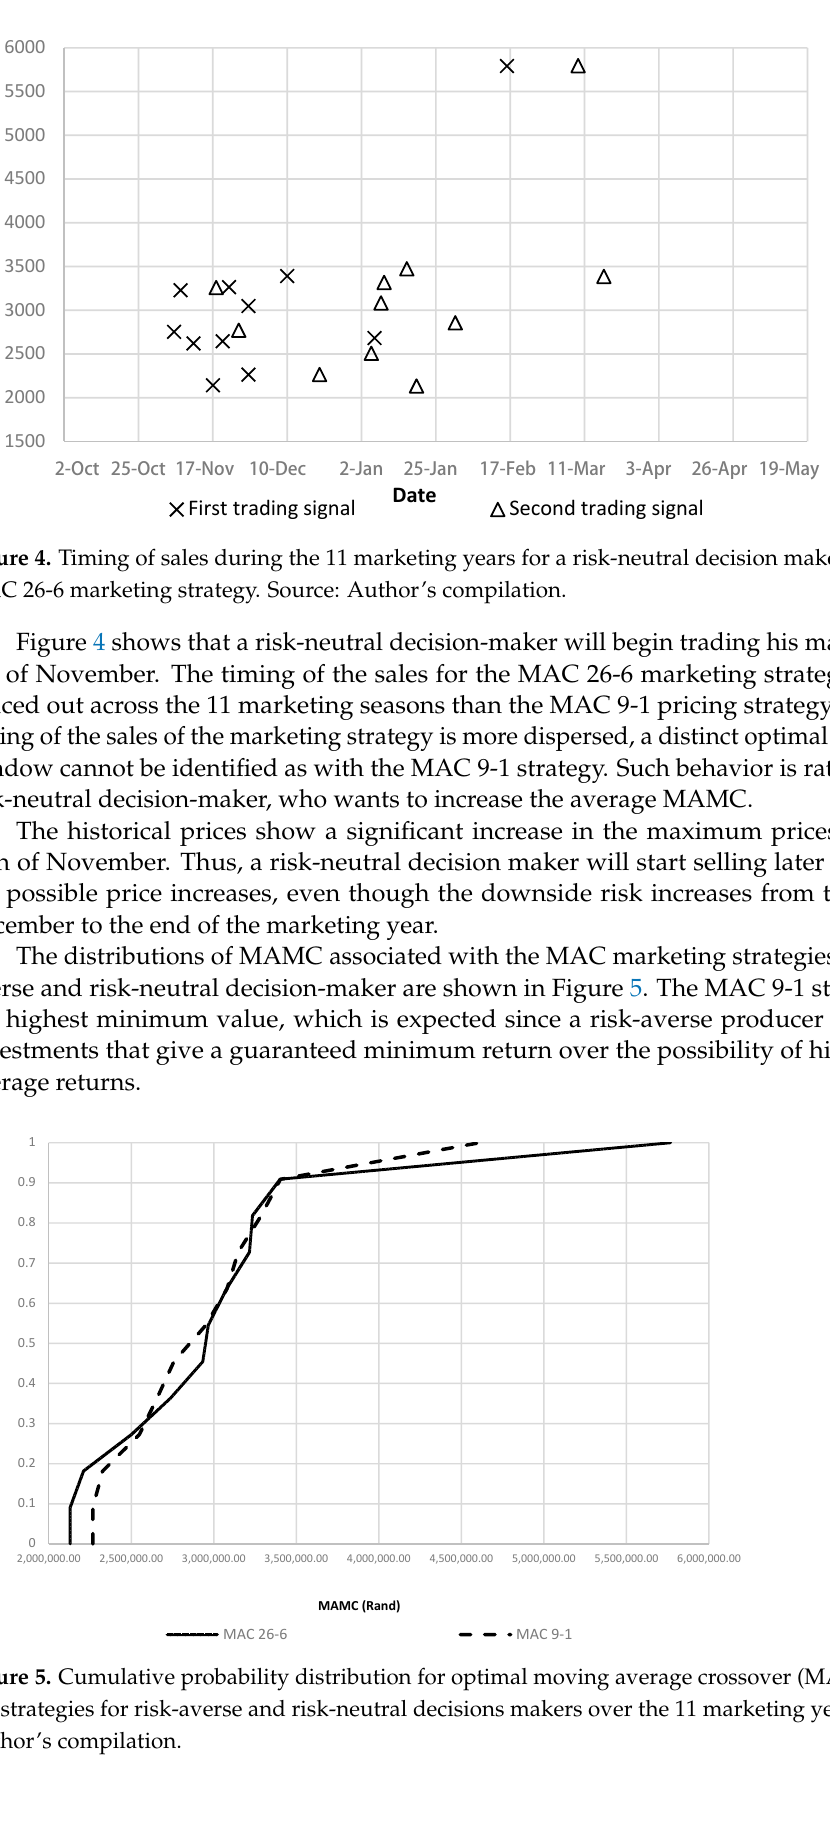
Figure 3. Timing of sales during the 11 marketing years for a risk-averse decision-maker using the